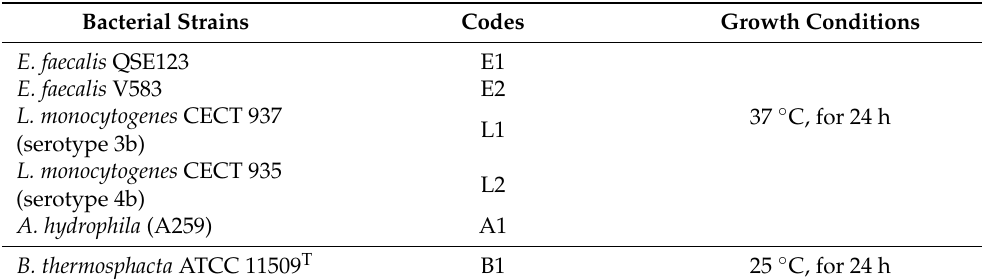
Table 1. Growth conditions and terminology used for the strains included in this study.